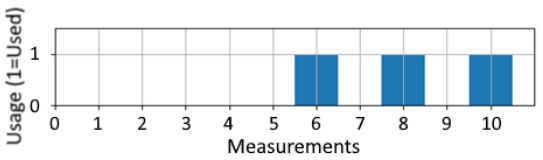
Figure 8. Example of the window size with 10 measured values. The step size s = 2 and the number of used steps n = 3.